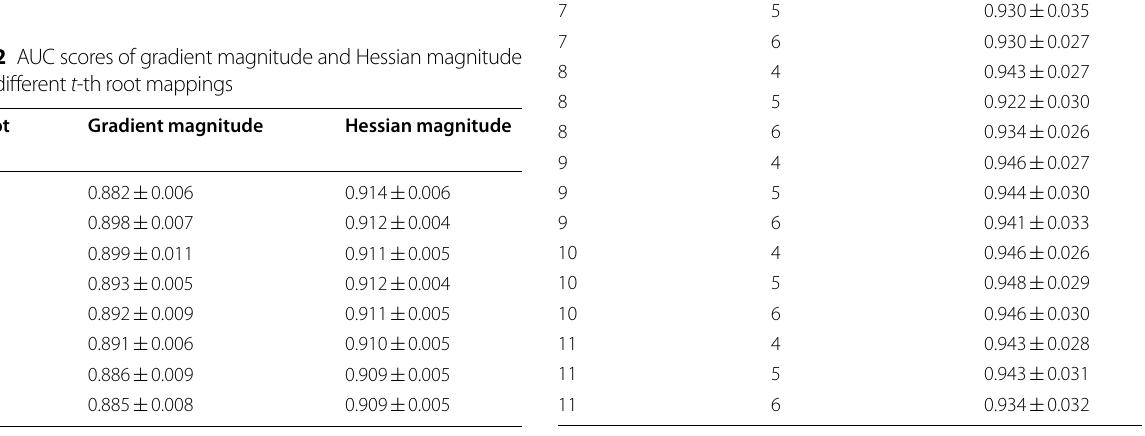
) with quantization between 28 1